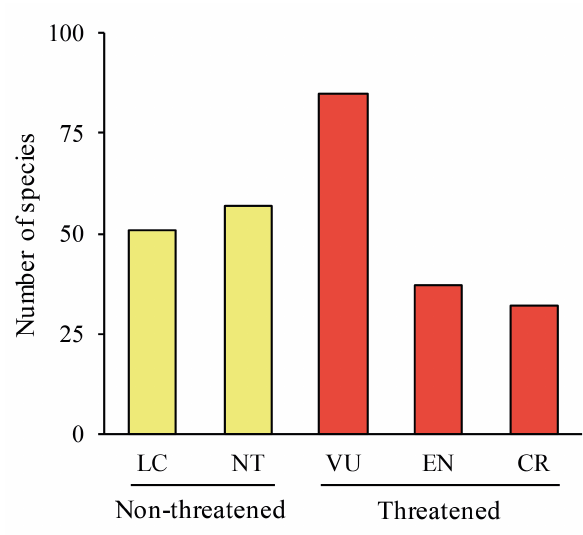
Figure 1. Number of non-threatened (yellow) and threatened (red) species in the endemic